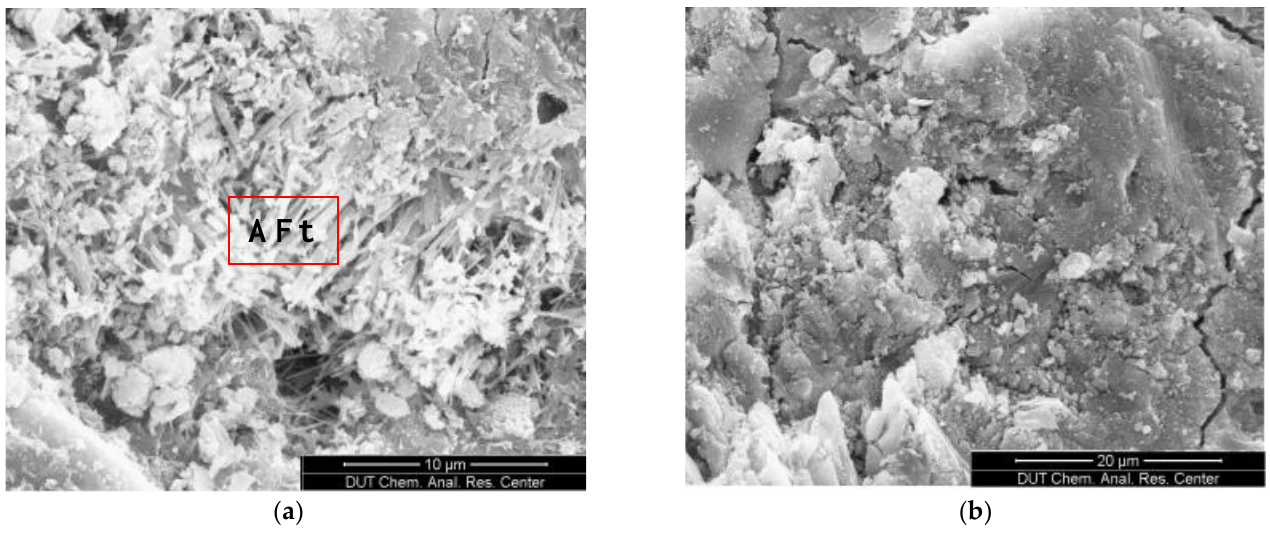
Figure 8. SEM images of concrete in a compound salt environment ( a ) without admixture and ( b ) with 60% slag.